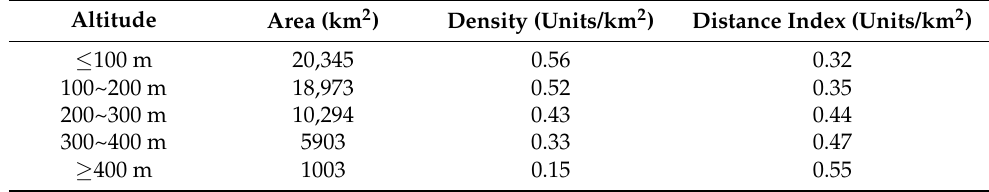
Table 3. Landscape index of spatial distribution of rural settlements at different